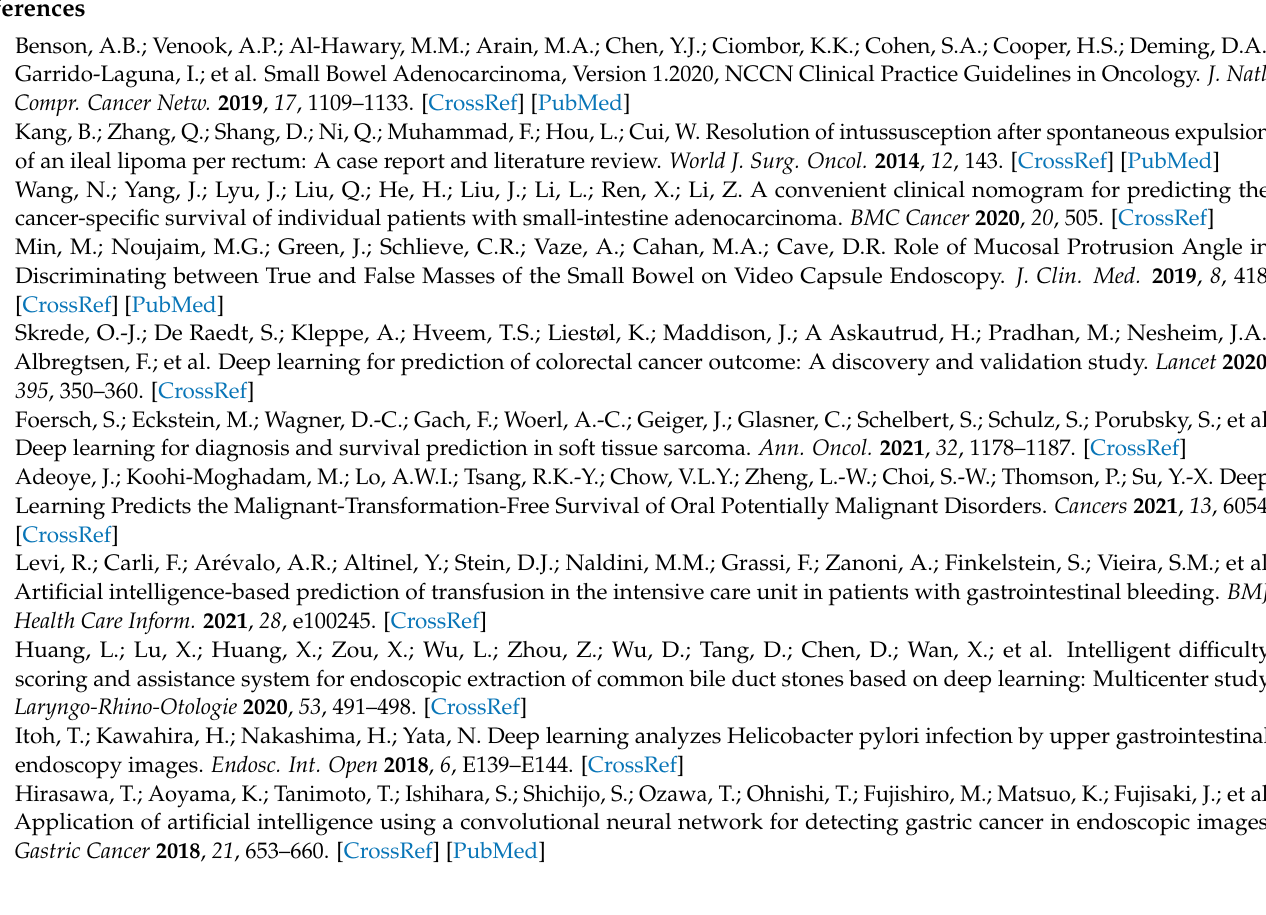
N2. Table S1: C-indices of Cox-PH and DeepSurv models based on different